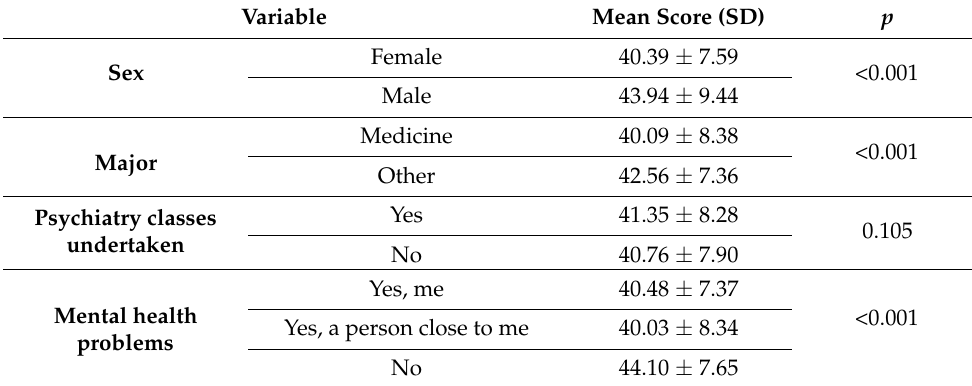
Table 2. Mean MICA-2 score.